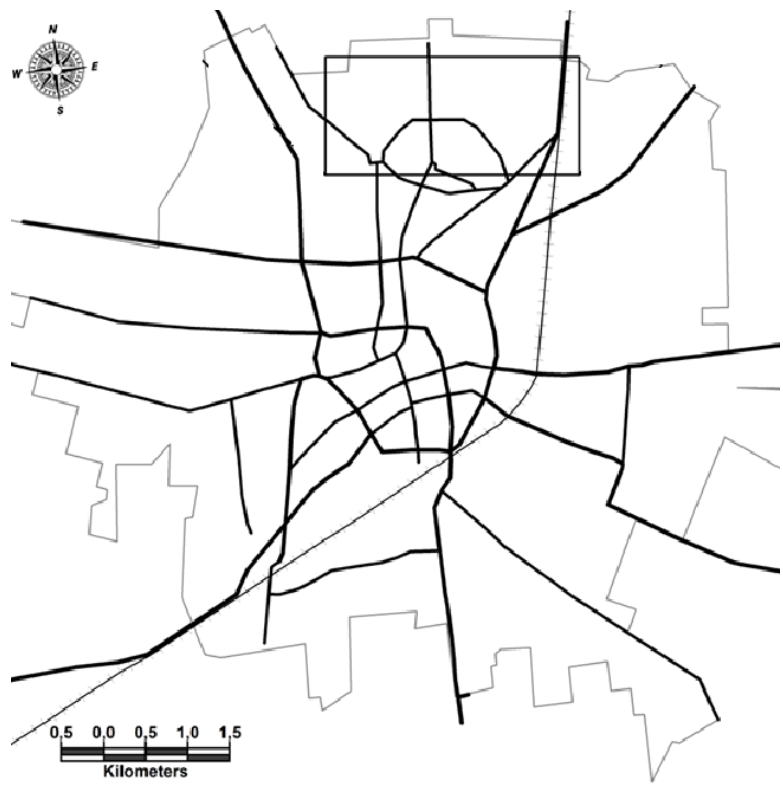
Figure 2. Location of Great Forest in Debrecen Source: own work.